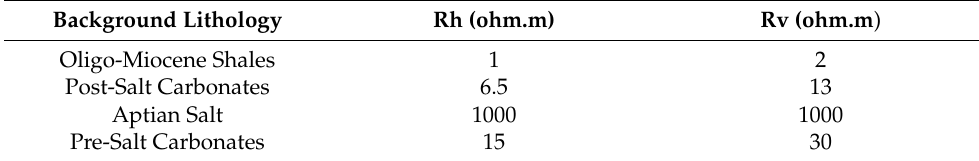
Table 1. Resistivity values of the background geology according to the MR3D model.